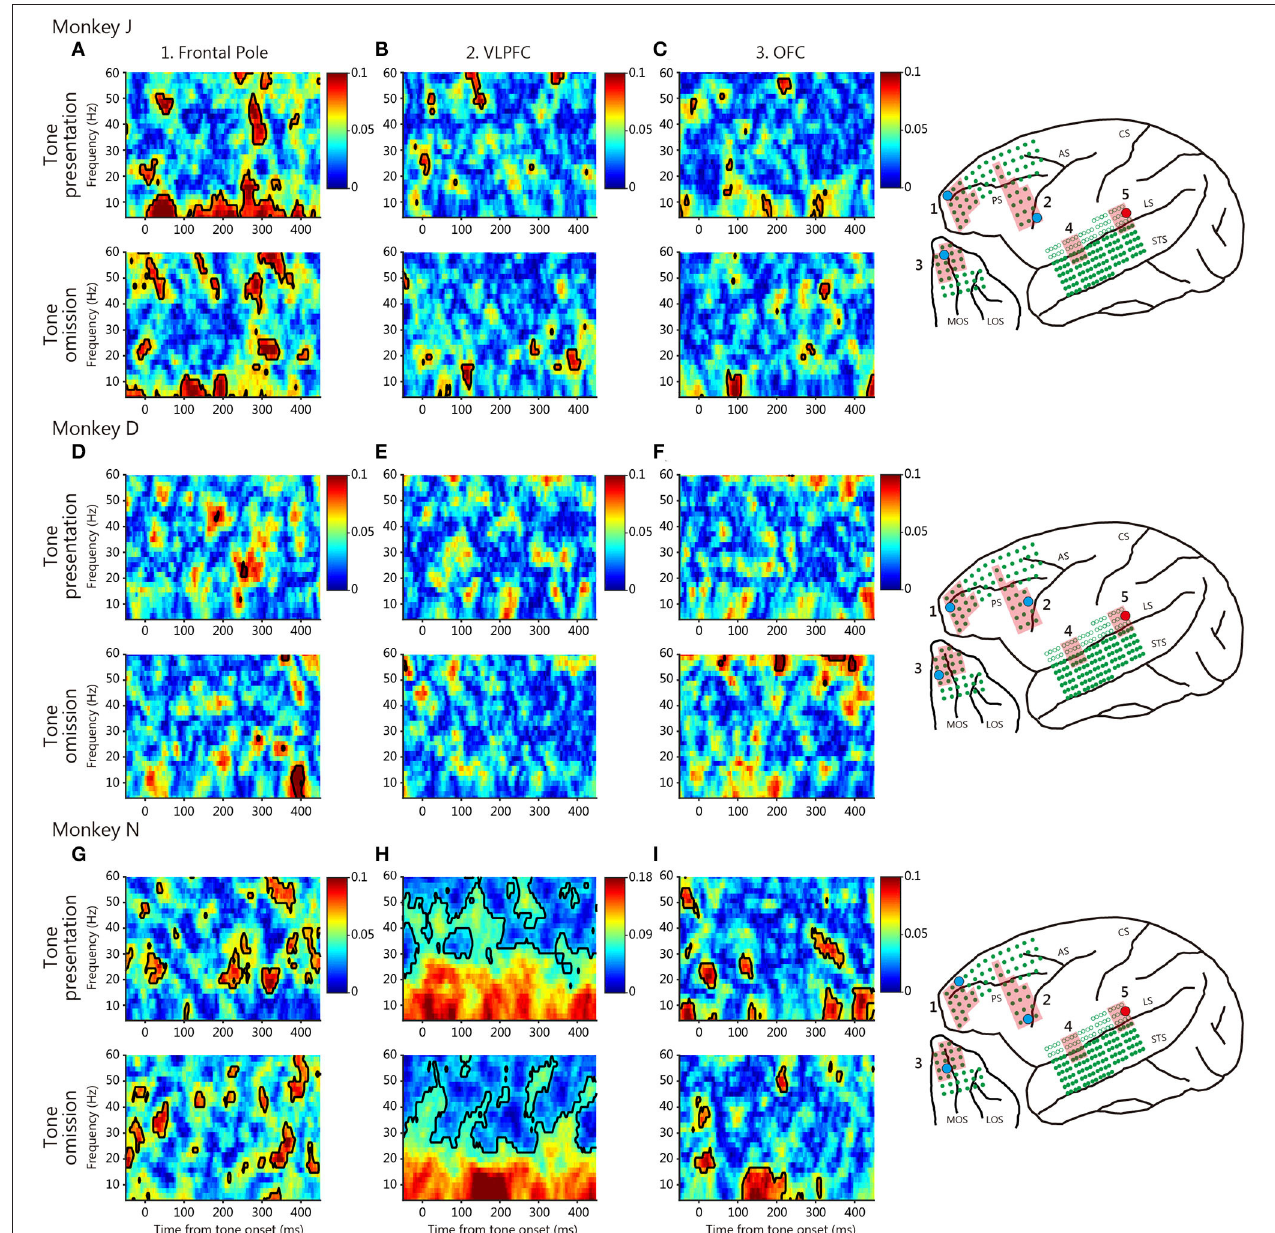
FIGURE 4 | Typical phase-locking values (PLVs) between the posterior temporal cortex and various prefrontal cortical regions. The conventions are those of Figure 3 .